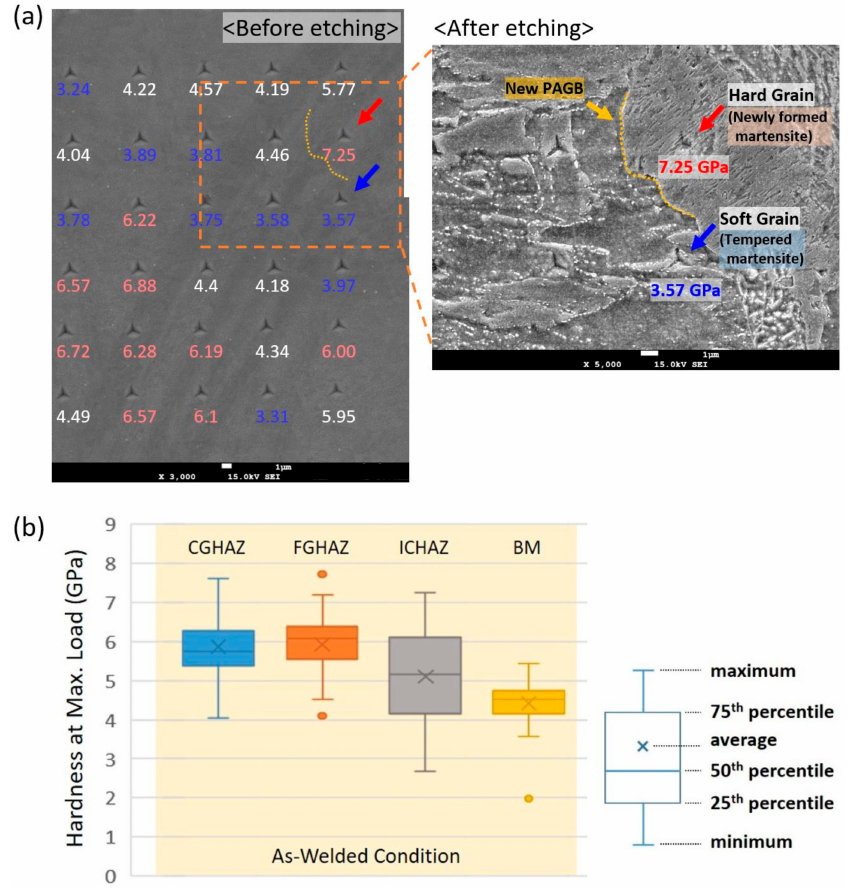
Figure 8. Results of nano-indentation test: ( a ) microstructure of the ICHAZ in the as-welded condition (hardness values are presented in the figure) and ( b ) boxplot analysis of each subzone